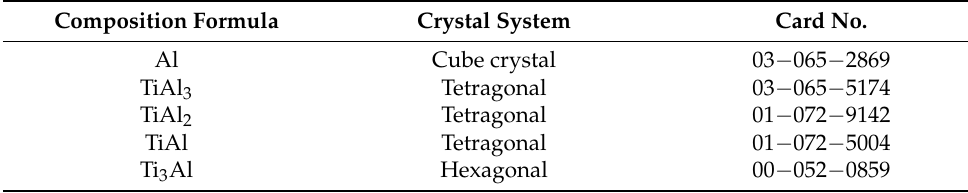
Table A1. International center for diffraction